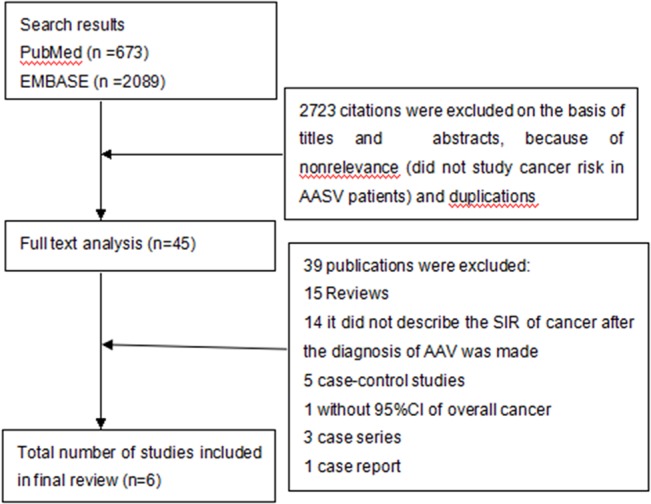
Literature search flow diagram.